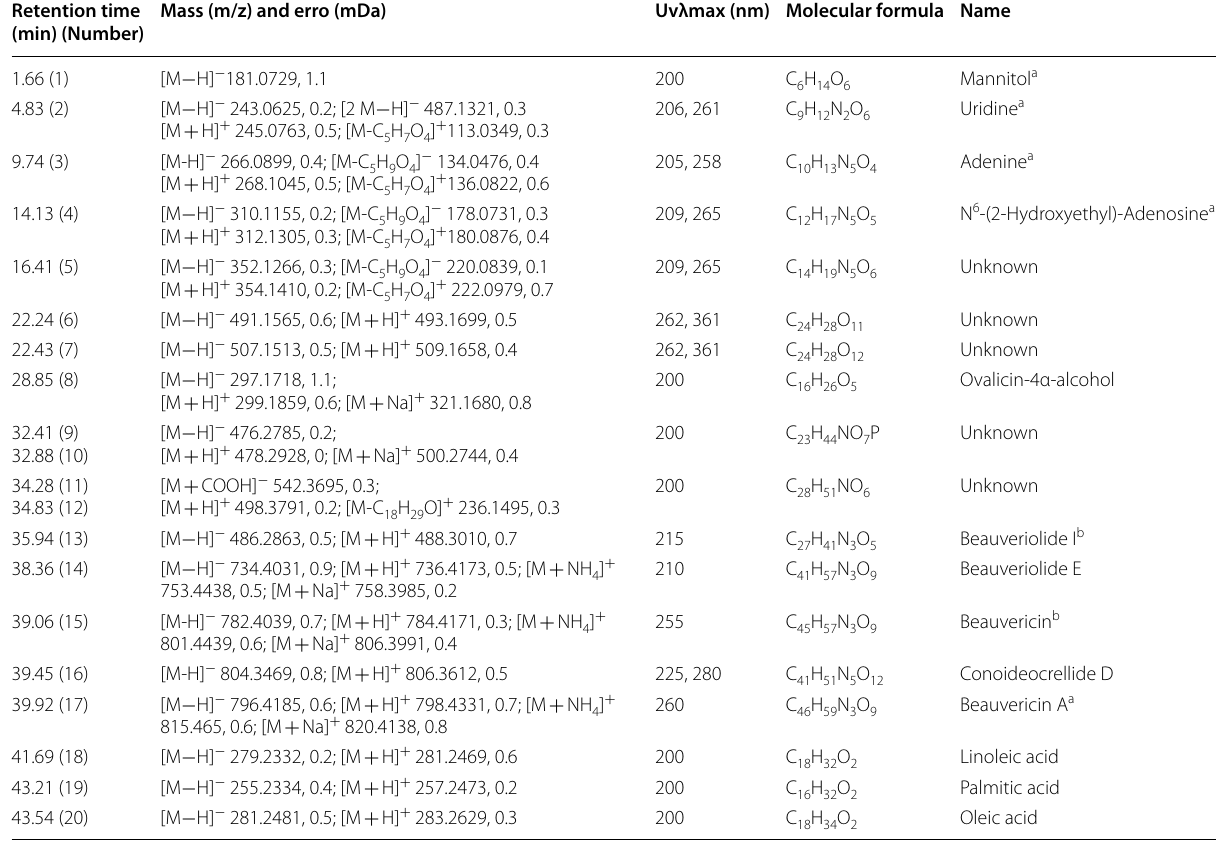
a Confirmed with standards b Have been reported from Cordyceps fumosorosea , Isaria fumosorosea or Paecilomyces fumosoroseus 33–35